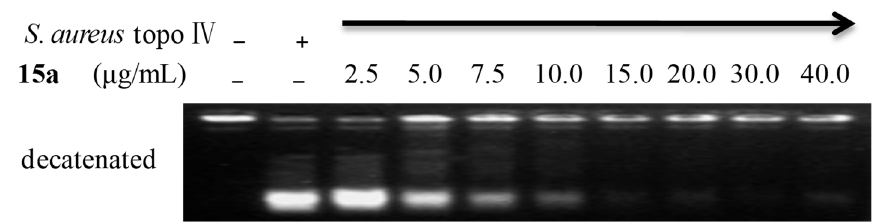
Figure 3. Inhibition of S. aureus topo IV. In all panels, enzyme and 15a are absent (-) in lane 1, enzyme present (+) and 15a absent in lane 2, and enzyme (arrow) and 15a present in lanes 3–10 with different concentration. Decatenation activity of topo IV was partially blocked by 15a (lanes 4, 5, 6) and completely blocked by 15a (lanes 7, 8, 9, 10).